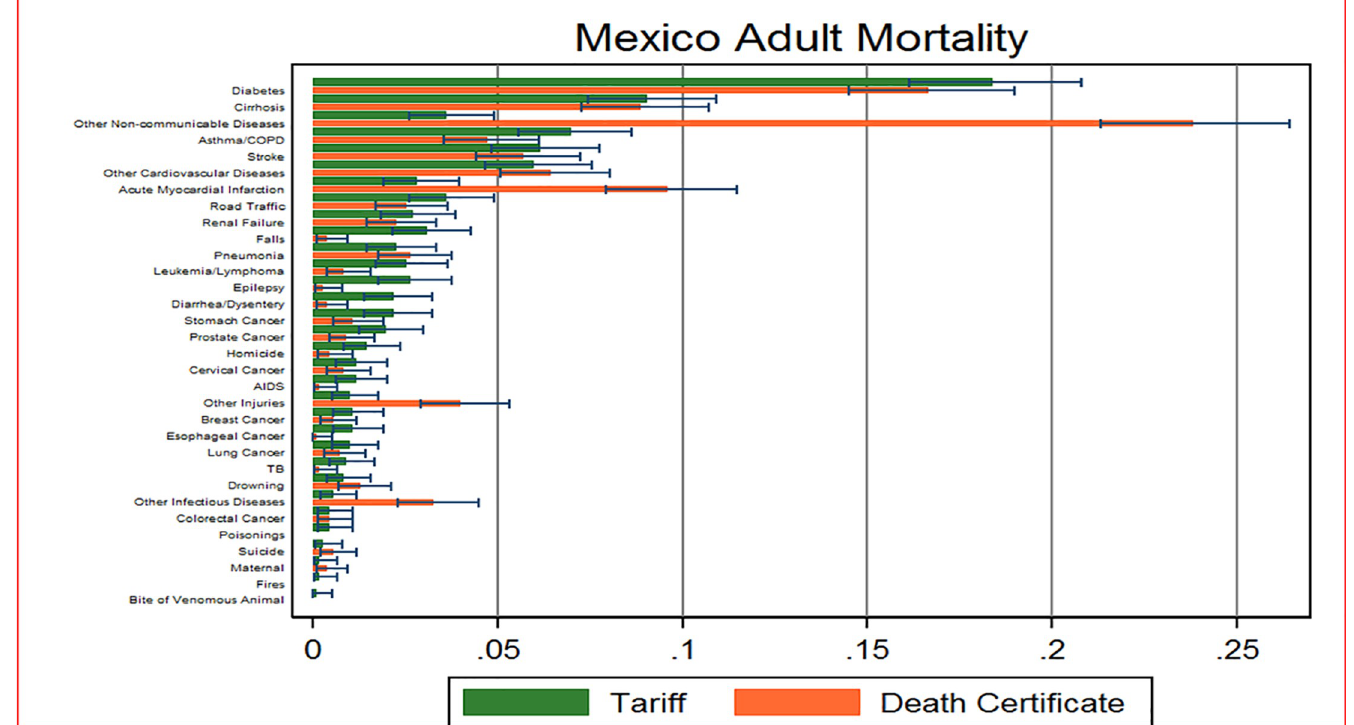
Fig 2. Comparison of adult mortality fraction calculated by VAs vs. vital statistics, Hidalgo, Mexico 2009 (n = 1,104).